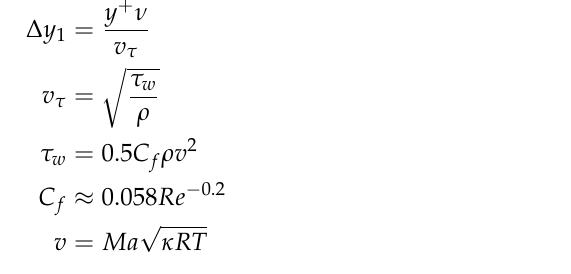
Table 3. Parameters of prism layer Parameter